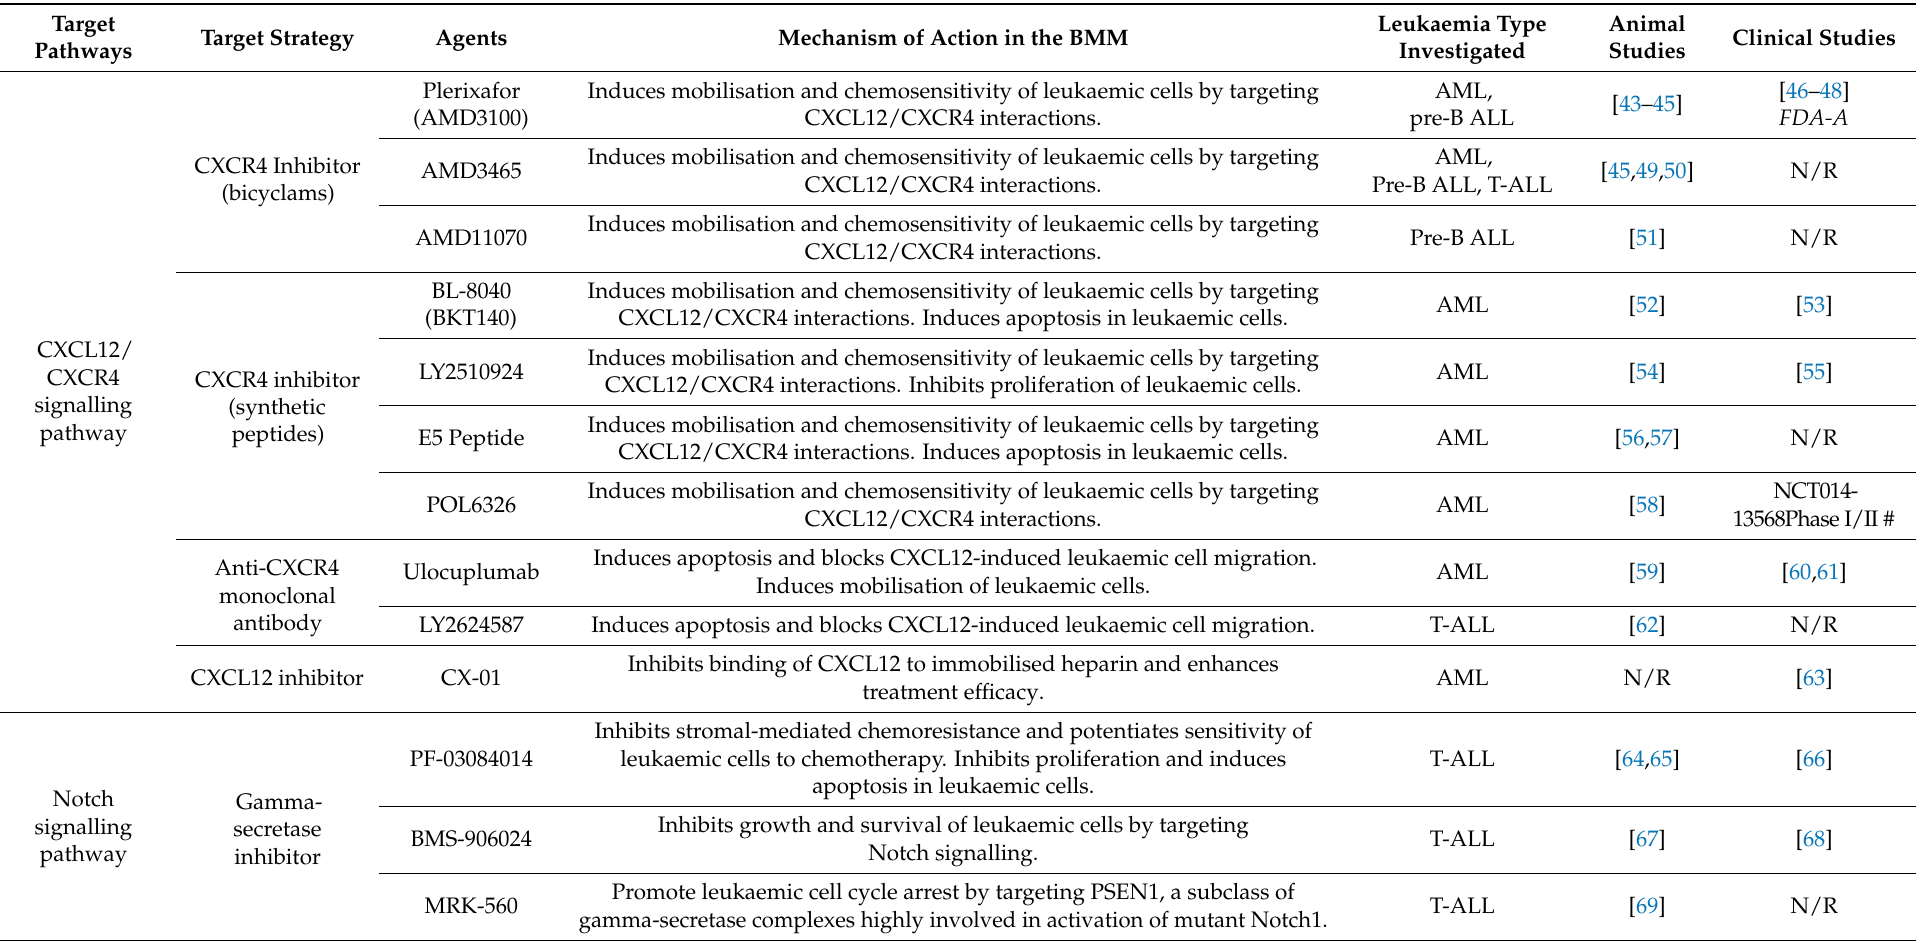
Table 1. Summary of therapeutic agents that target the leukaemic niche in the bone marrow